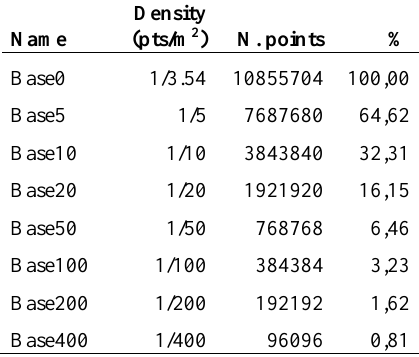
Table 3. Grugliasco test site, input subsets